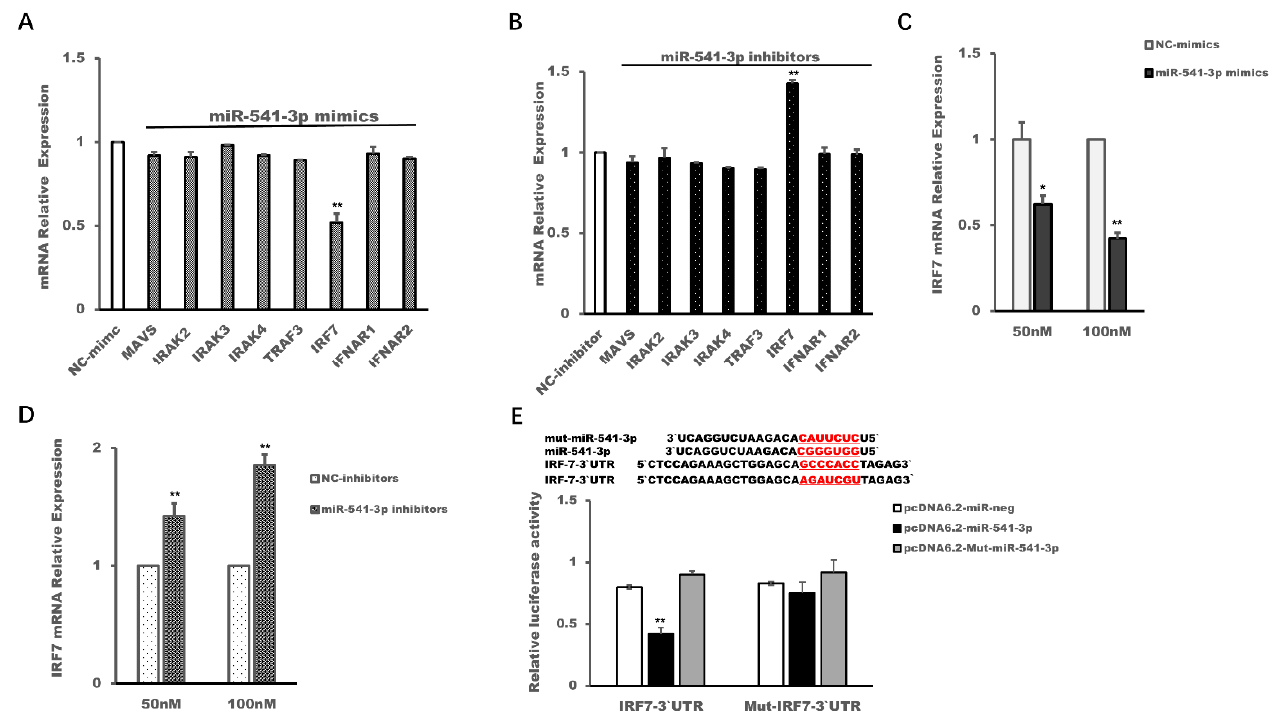
Figure 4. Interferon regulatory factor 7 (IRF7) was a target gene of miR-541-3p. HEK 293T cells were transfected with miR-541-3p mimics ( A ), miR-541-3p inhibitors ( B ), NC-mimics or NC-inhibitors. Then, 48 h later, the expression of predicted target mRNAs of miR-541-3p was measured by quantitative real time polymerase chain reaction (qRT-PCR) . HEK 293T cells were transfected with miR-541-3p mimics at a final concentration of 50 nM or 100 nM ( C ), miR-541-3p inhibitors at a final concentration of 50 nM or 100 nM ( D ) and NC-mimics or NC-inhibitors. Then, 48 h later, the expression levels of IRF7 were measured by qRT-PCR. ( E ) Schematic presentation of base pairing between the 3 (cid:48) untranslated region (UTR) of IRF-7 and the miR-541-3p sequence; the underlined red bases are their paired bases and their corresponding mutant bases. HEK 293T cells were transfected with the pcDNA6.2-miR-541-3p or pcDNA6.2-Mut-miR-541-3p and psiCHECK-2-IRF7-3 (cid:48) -UTR or psiCHECK-2-Mut-IRF7-3 (cid:48) -UTR, and 24 h later, the cells were harvested for luciferase activity assay by using the dual-luciferase reporter assay system. All experiments were repeated at least three times with similar results. * p < 0.05; ** p < 0.01.